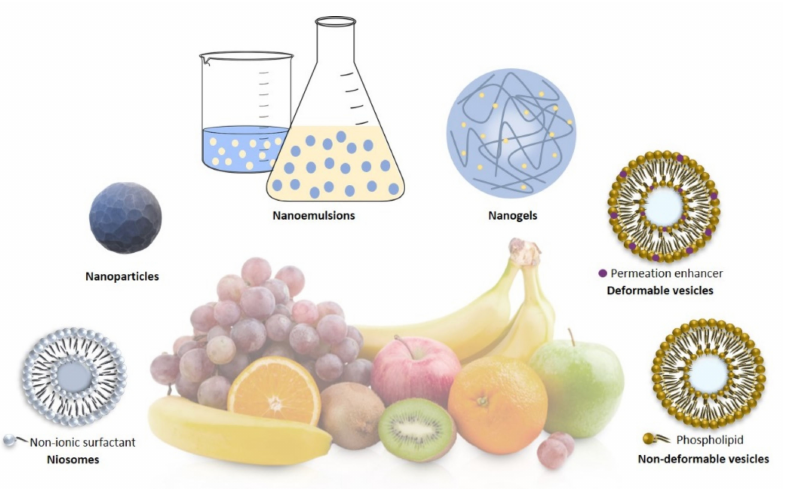
Figure 2. In this picture, some nanocarriers used for the delivery of nutraceuticals are